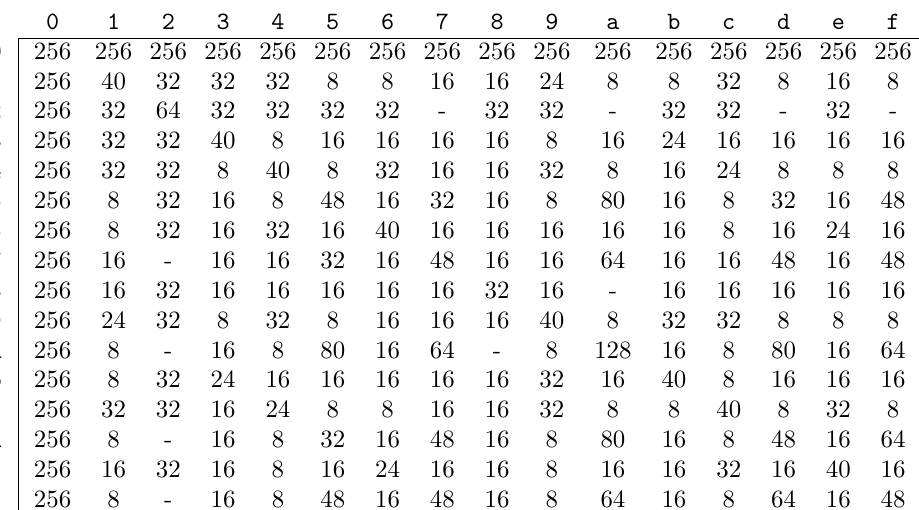
Table 13: DBCT of CRAFT ’s 4-bit